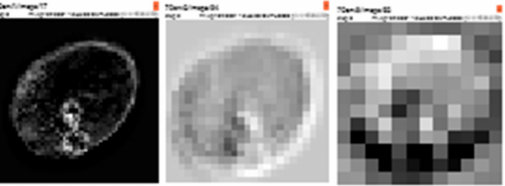
Figure 13. Convolution visualization results for an insect-n feature extracted by the new network-dr- pv model (Convolutional Layers